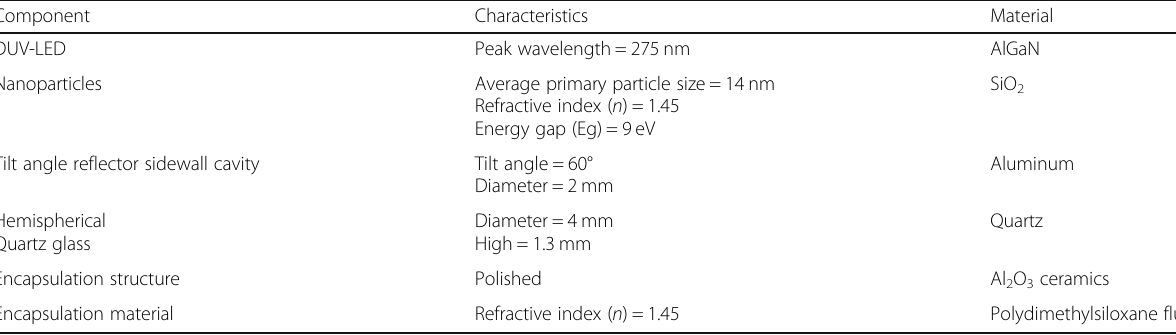
Table 1 Materials and characteristics of DUV-LED Component